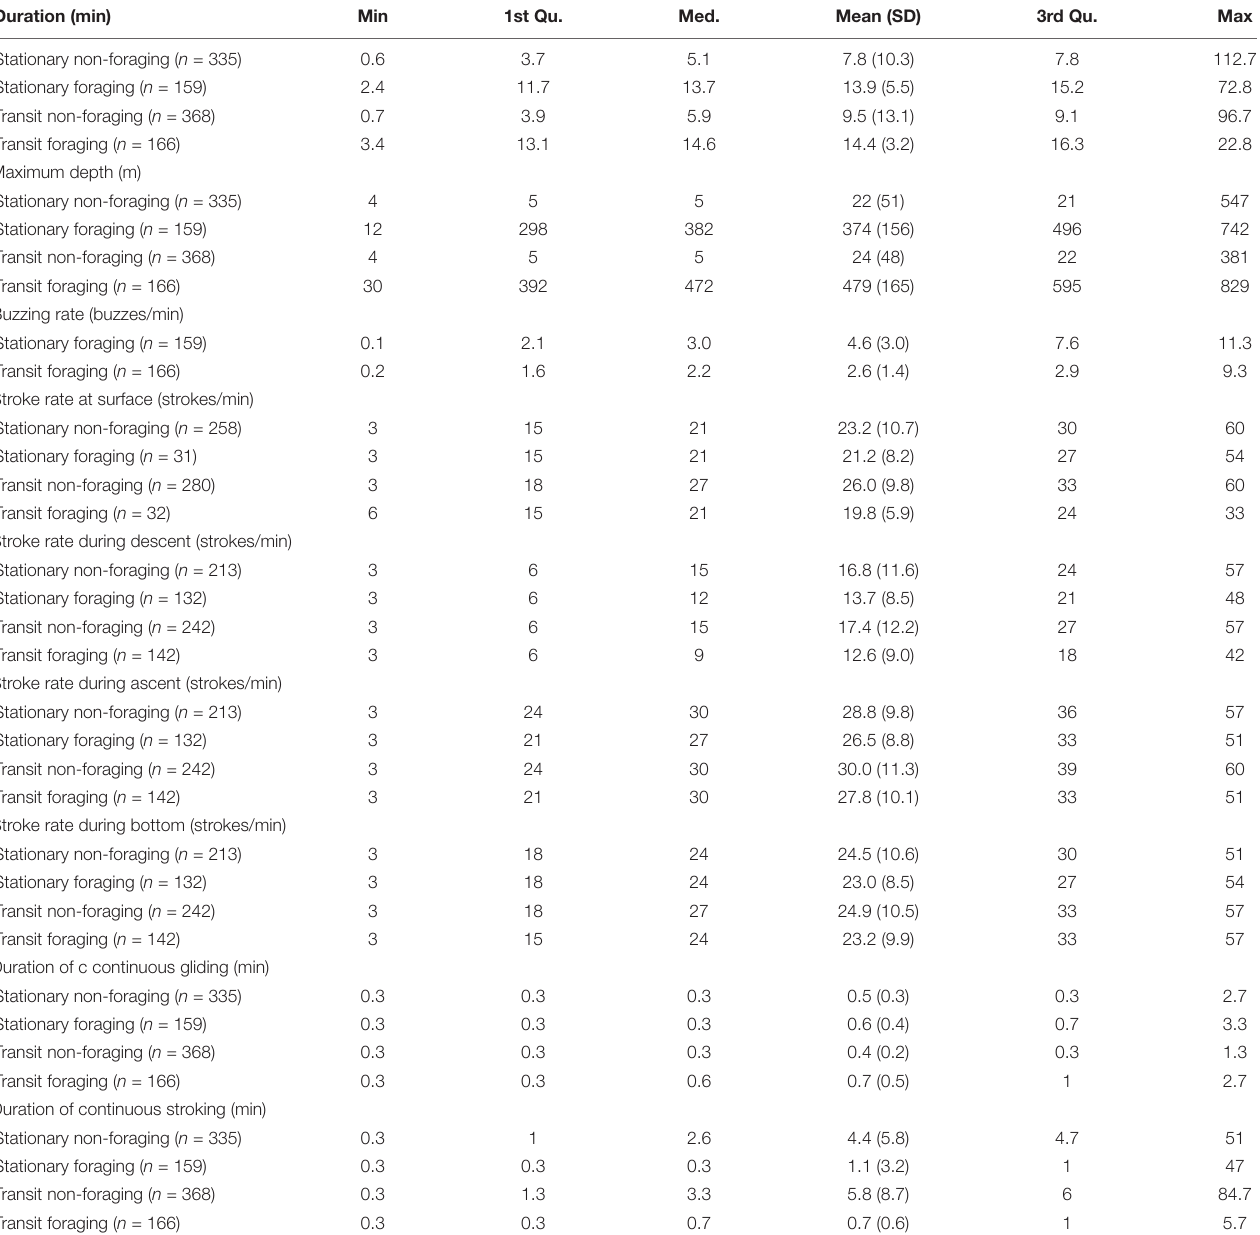
TABLE 6 | Descriptive statistics for bcpa behavioral